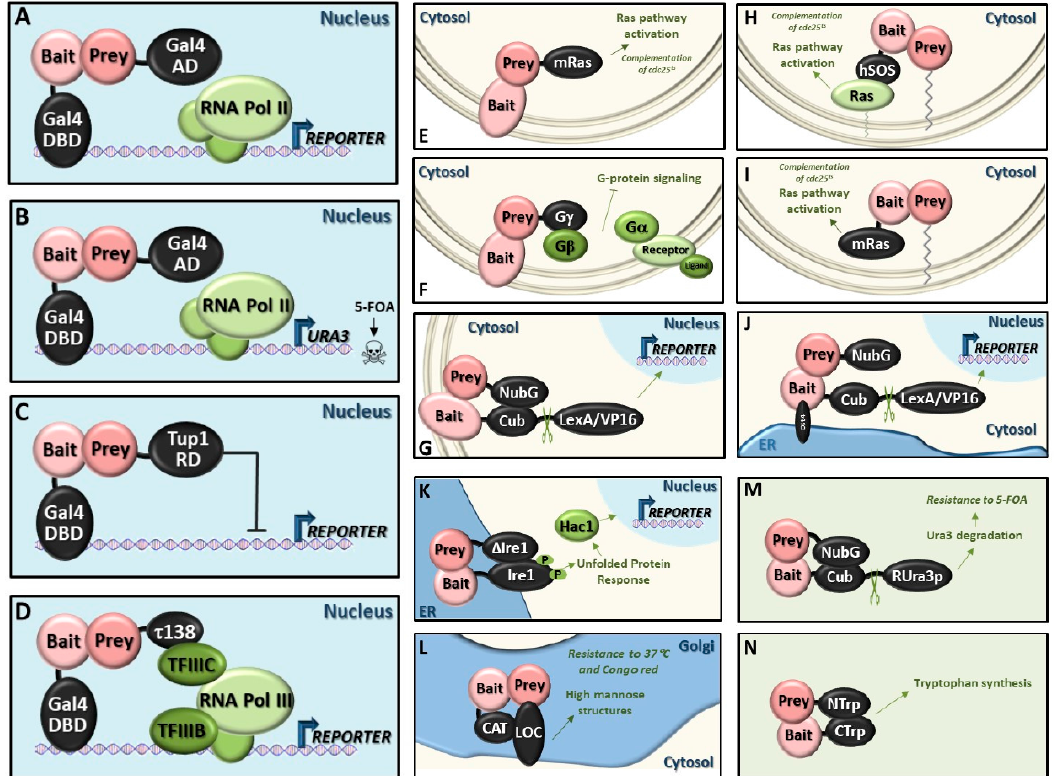
Figure 3. Diagram of the techniques for detecting protein–protein interactions in yeast. ( A ) Classic Y2H system. ( B ) Reverse Y2H system. ( C ) Repressed transactivator system. ( D ) RNA polymerase III system (the τ 138 subunit is encoded by the TFC3 gene). ( E ) Reverse Ras recruitment system. ( F ) Heterotrimeric G-protein fusion system. ( G ) Membrane split-ubiquitin system. ( H ) SOS recruitment system. ( I ) Ras recruitment system. ( J ) Cytosol split-ubiquitin system. ( K ) SCINEX-P system. ( L ) Golgi complex system (CAT: Catalytic domain Och1; LOC: Och1 domain required for membrane attachment). ( M ) Generally applicable split-ubiquitin system. ( N ) Split-Trp system. The subcellular location within a yeast cell and the operating mode (at the moment of bait-prey interaction) is represented. See text for more